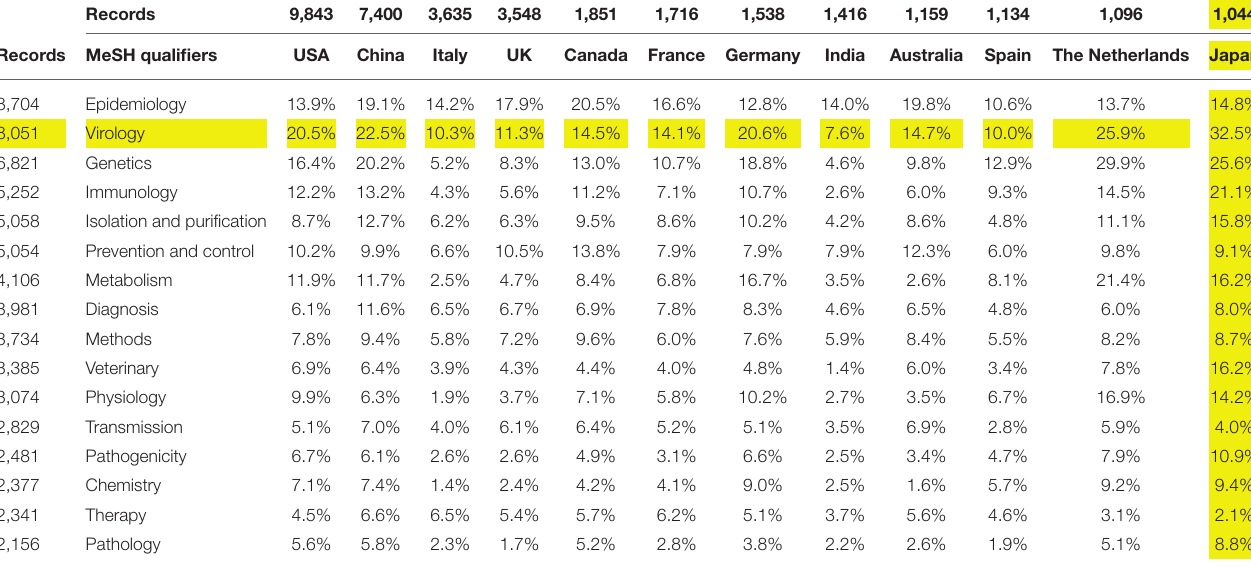
TABLE 2 | COVID-19 topics (top 16 MeSH Qualifiers) by country (top 12), for all years (47,607 records).